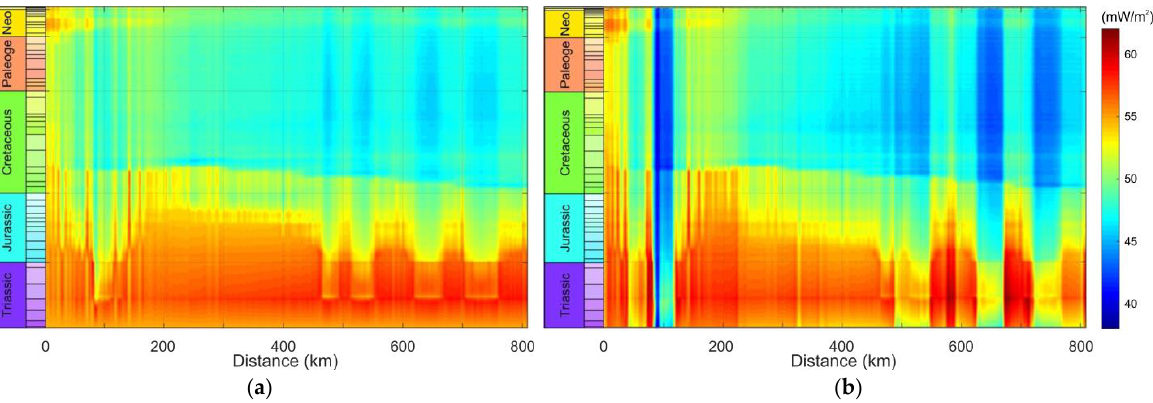
Figure 9. Heat flow histories of the basement surface: ( a ) Model 1 and ( b ) Model 2; the density colour code applies to both images.